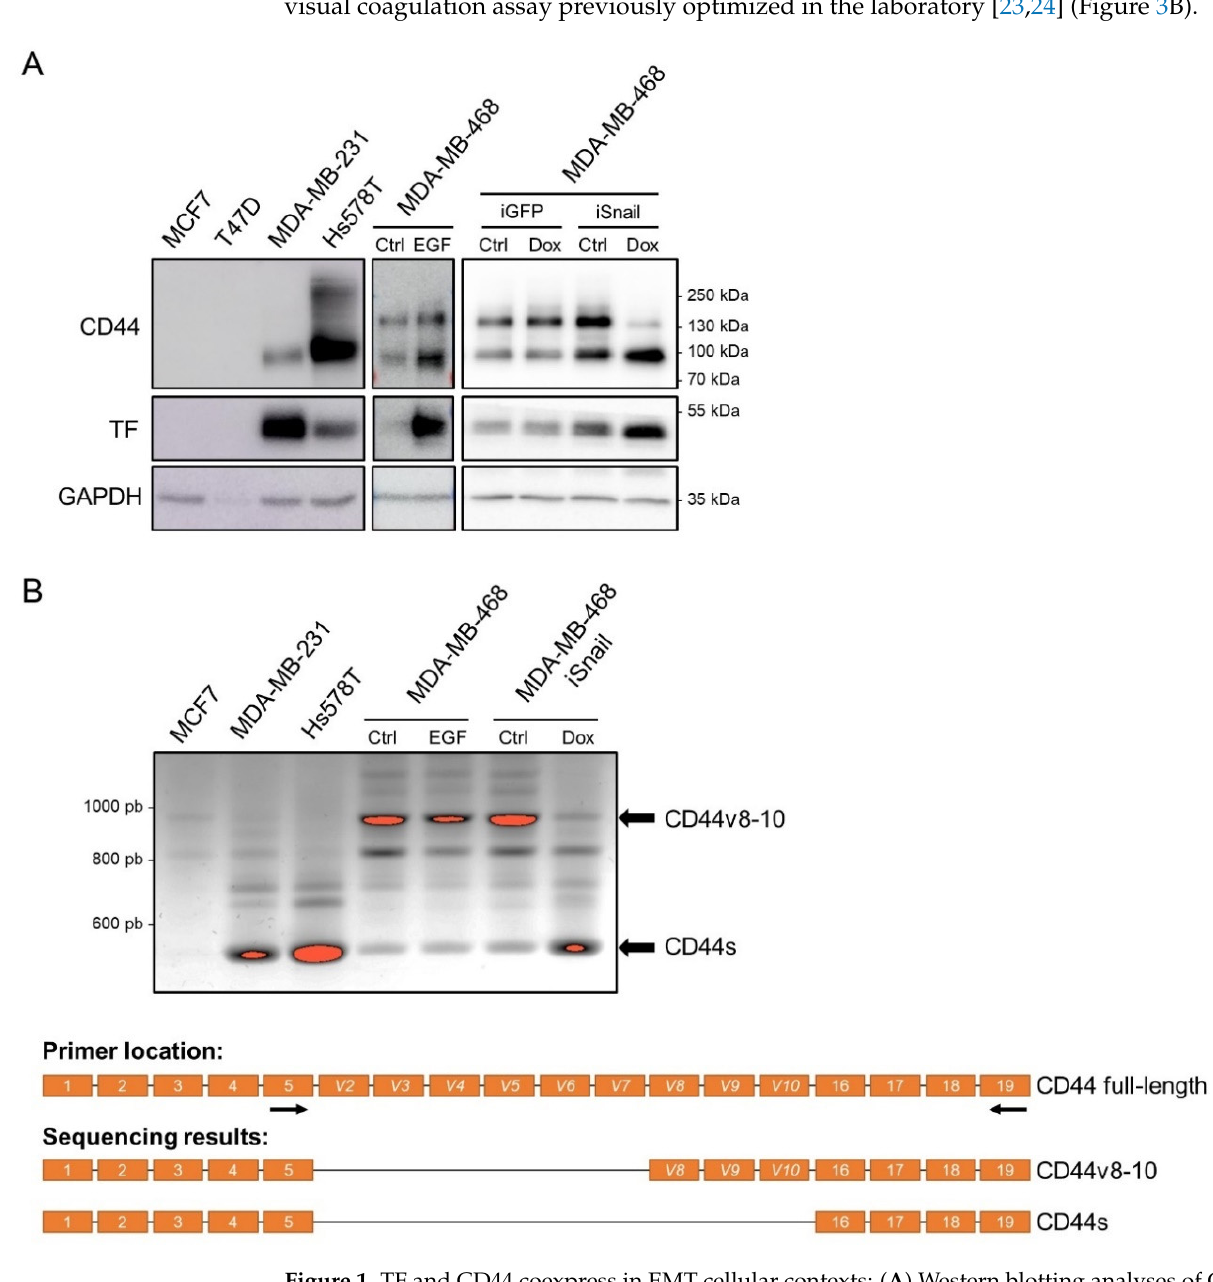
Figure 1. TF and CD44 coexpress in EMT cellular contexts: ( A ) Western blotting analyses of CD44, Tissue Factor (TF) and GAPDH in Epithelial-Mesenchymal Transition-positive (EMT + : MDA-MB-231 and Hs578T), EMT-negative (EMT − : MCF7 and T47D) and EMT-inducible models: MDA-MB-468 treated or not (Ctrl) with EGF and MDA-MB-468 iSnail or its control iGFP treated or not (Ctrl) with doxycycline (original western blot images are shown in Supplementary Materials). ( B ) Sequencing analyses of major CD44 isoforms present in different cell lines as indicated. An end-point RT-PCR (top panel) using a forward primer located in the fifth exon and a reverse primer located in the nineteenth exon of the human CD44 gene (as shown in the schematic representation in the bottom panel) was performed. The two major amplicons (appearing as saturated bands in red on the gel) were extracted from the gel and sequenced. The sequencing results clearly revealed two major isoforms (CD44v8-10 and CD44s) as indicated on the cartoon. (Figure S3: Uncropped Western blot